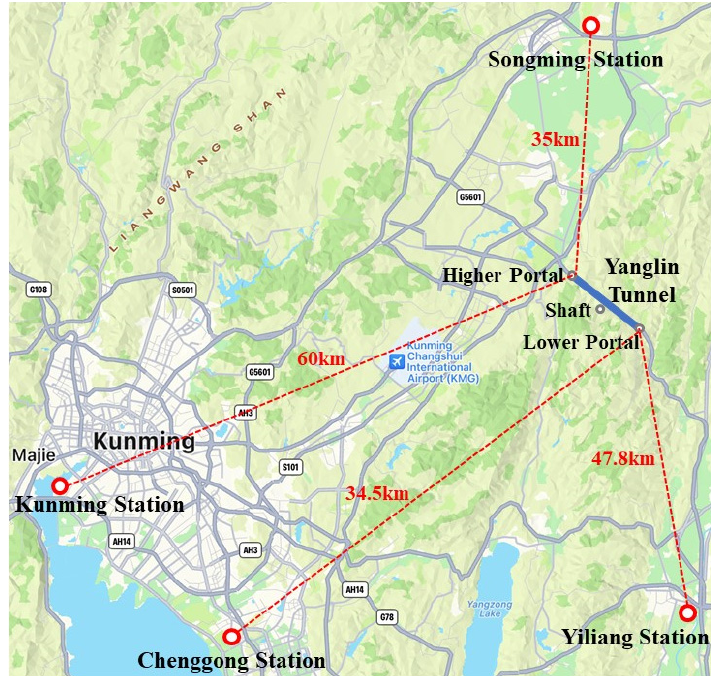
Figure 1. Geographical location map of the four national stations and tunnel portals.